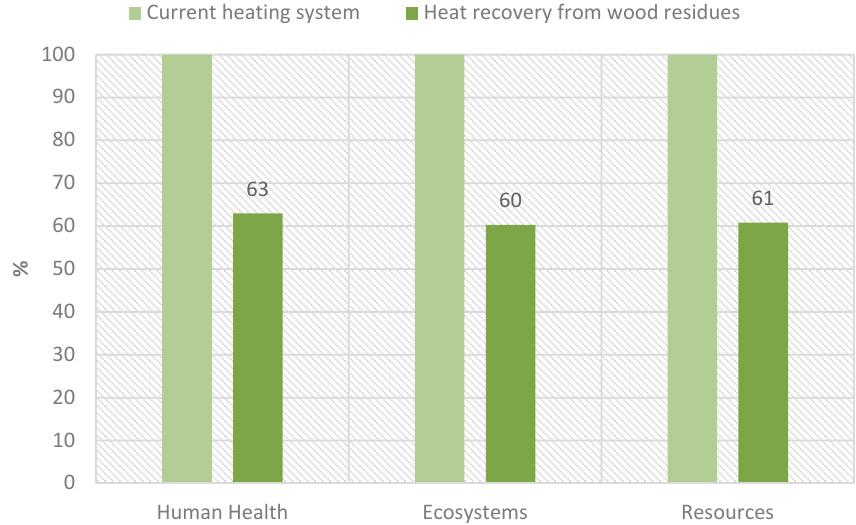
Figure 8. Damage assessment distribution among the two scenarios.